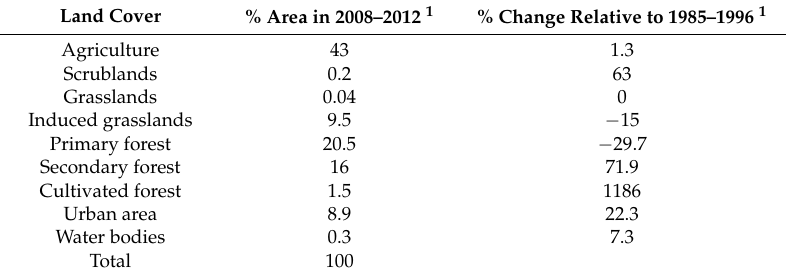
Table 3. Relative distribution of area of the Water Forest in the period 2008-2012 and % change relative to 1985–1996.